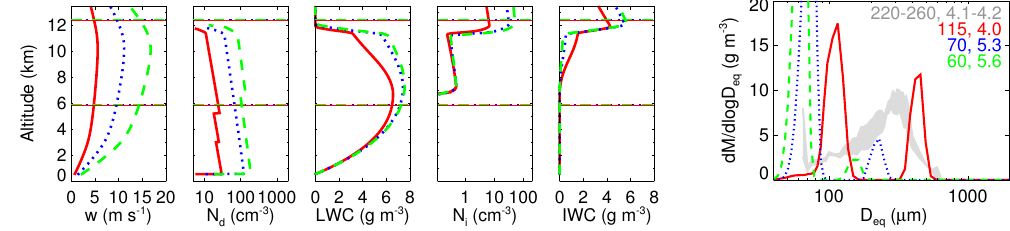
Figure 9. As in Fig. 6 for simulations that also allow sedimentation with parcel depth (cid:49)z = 1km.